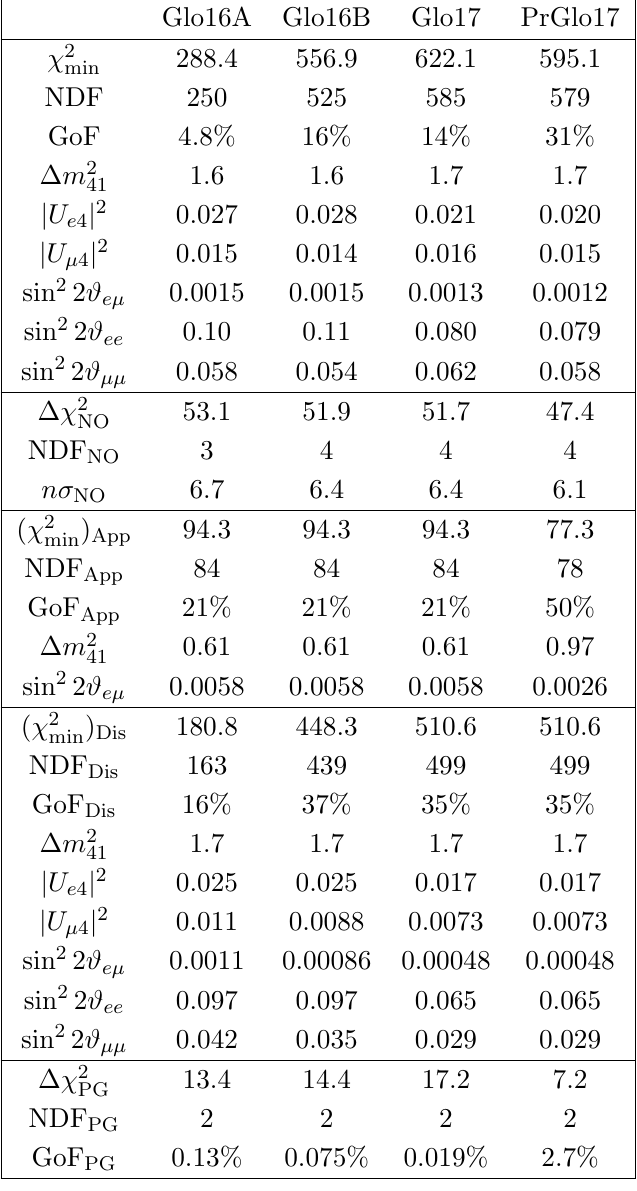
Table 5 . Results of the 3+1 global Glo16A, Glo16B, Glo17, and PrGlo17 (cid:12)ts of SBL data discussed, respectively, in subsections 3.2, 3.3, 3.4, and 3.5. The (cid:12)rst group of rows gives: the minimum (cid:31)